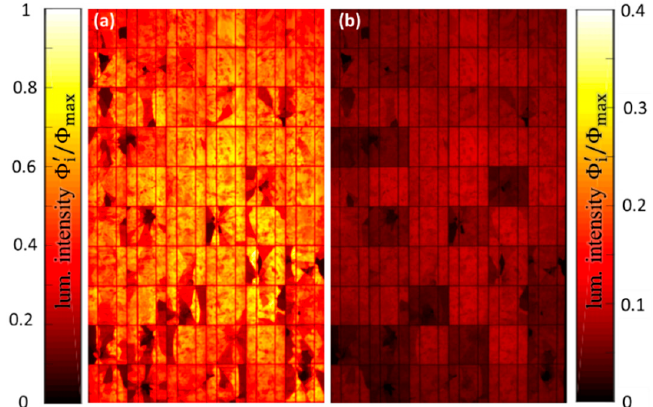
Figure 4. False color EL image of a hail-damaged photovoltaic module with 60 multicrystalline silicon solar cells (module A) at ( a ) supplied current of 37% of short circuit current I sc = 8.3 A with 100 s exposure time and ( b ) with 7% I sc with 360 s exposure time. The local intensities Φ (cid:48) in the low current EL image in ( b ) are downscaled proportional to the exposure time ratio. For the false color visualization, both images are normalized to the individual maximal luminescence intensity Φ (cid:2923)(cid:2911)(cid:2934) of the high current image in ( a ).